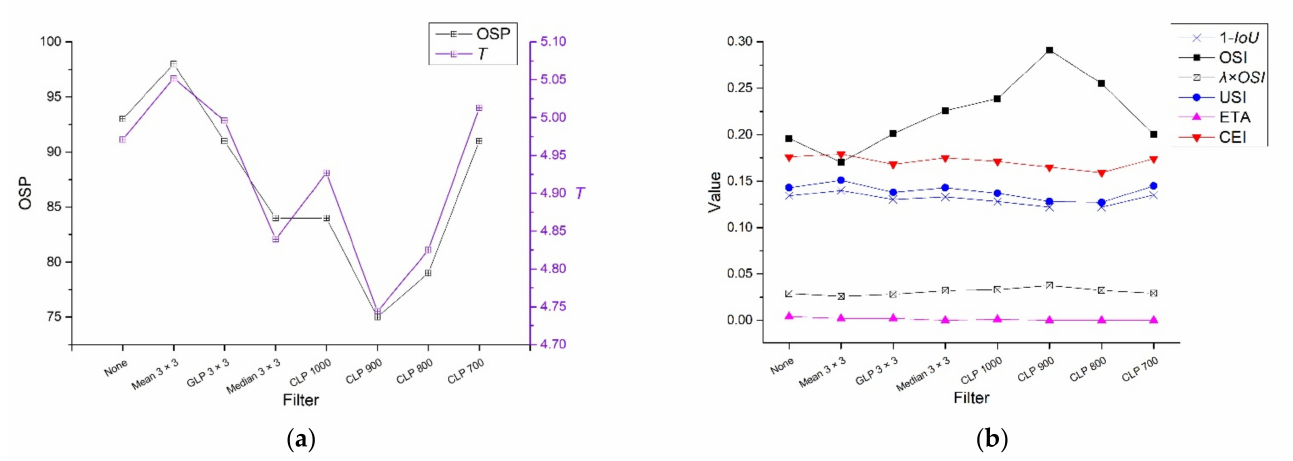
Figure 10. Effects of spatial filtering on segmentation evaluation parameters of ACFI compressed to MDN 255: ( a ) OSP and segmentation time; ( b ) segmentation evaluation